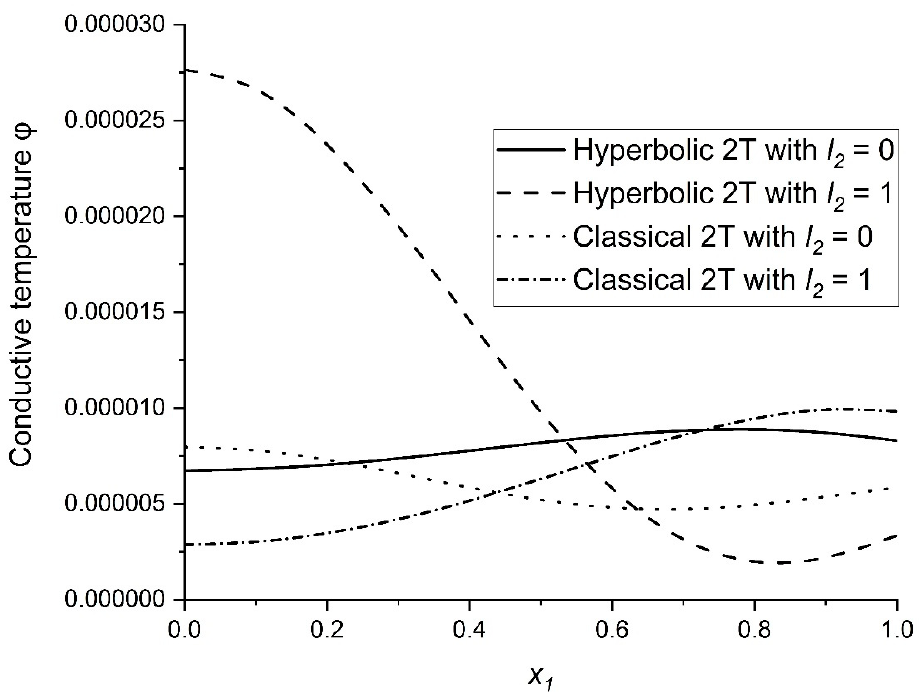
Figure 6. Variations in dimensionless conductive temperature 𝜑 .